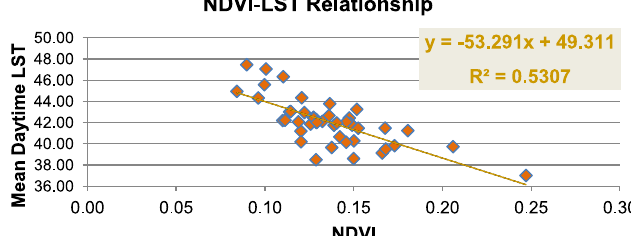
Fig. 5. NDVI and LST relationship in Cairo Governorate, Egypt. Source: